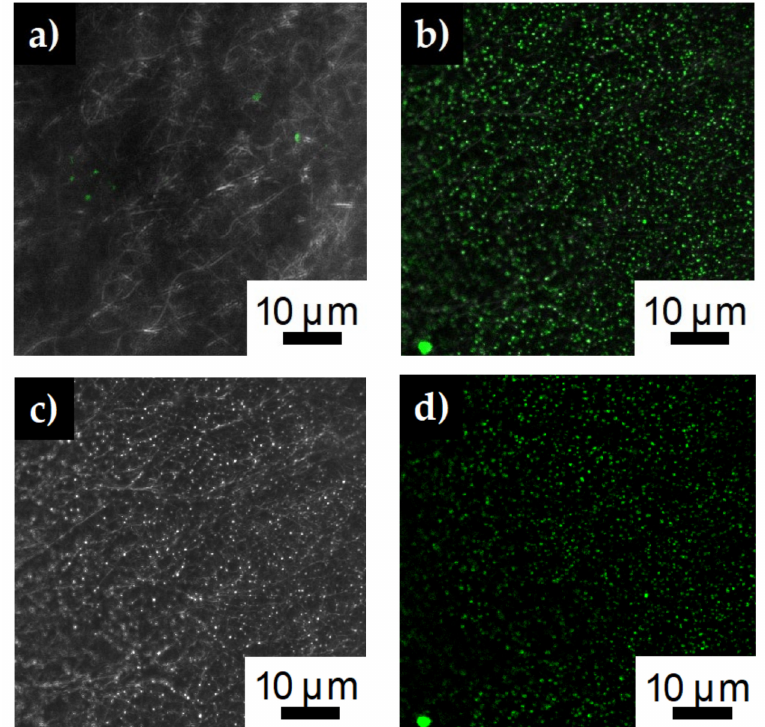
Figure 5. Confocal images after immersing ( a ) carbon nanofibers and ( b ) silver impregnated carbon nanofibers in PLL- g -PEG FITC solution for one hour. ( c ) Bright field image from confocal images showing silver nanofibers ( d ) 488 nm laser line of the confocal images showing the green fluorescence of the FITC immobilized on the fiber